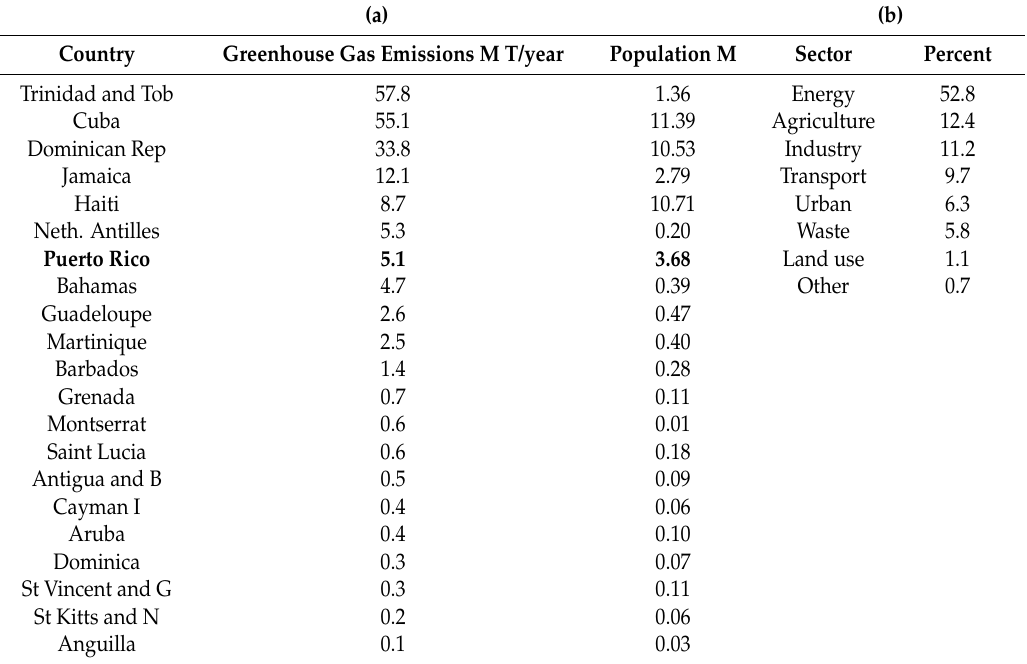
Table 1. ( a ) Greenhouse gas emissions (ranked) and population, and ( b ) contribution per sector in the